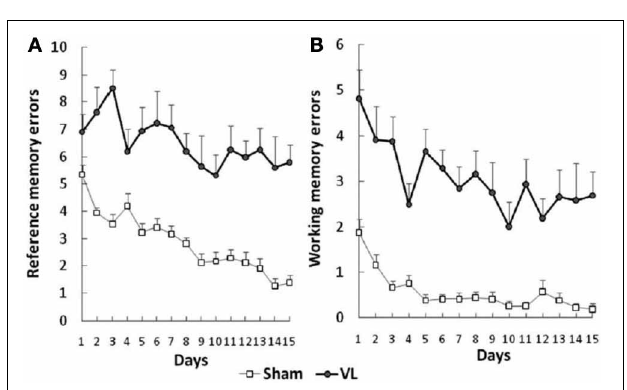
FIGURE 4 | Effects of sequential unilateral vestibular lesions on performance of rats, compared to sham controls, in a radial arm maze task. (A) Number of reference memory errors. (B) Number of working memory errors. Data are represented as mean ± s.e.m. Reproduced with permission from Besnard et al.